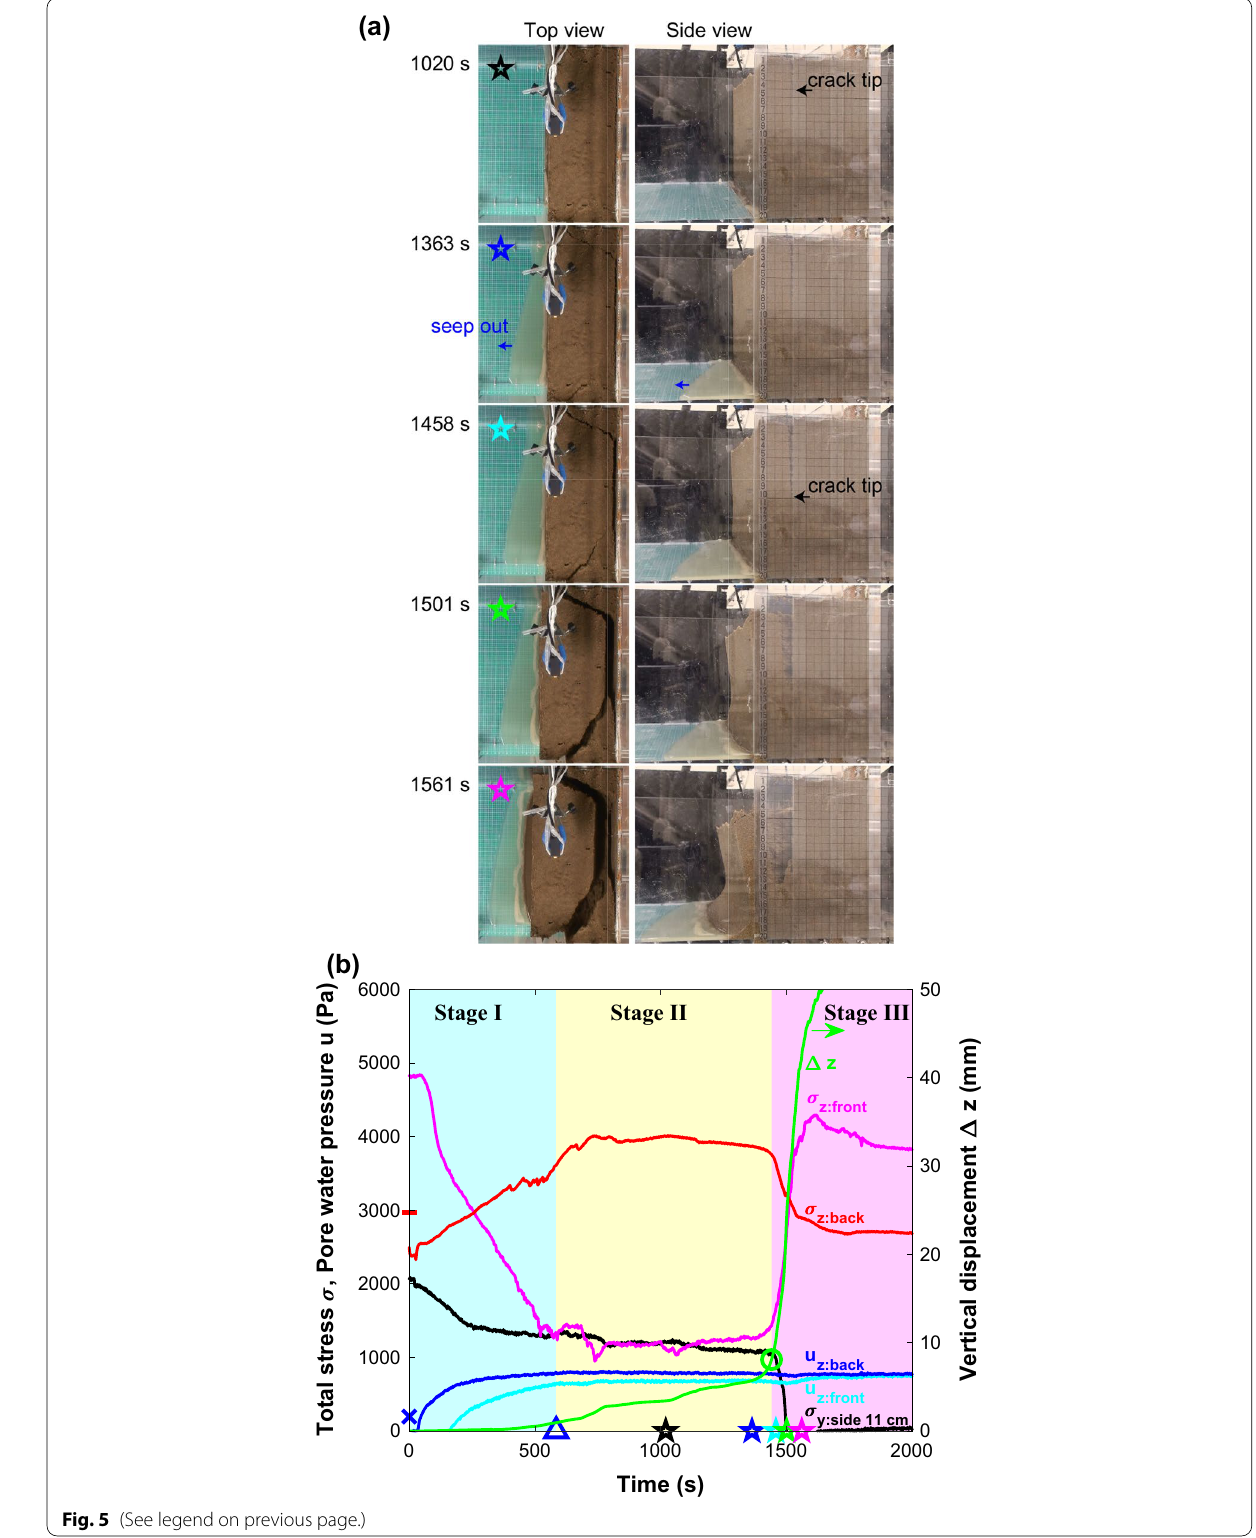
Fig. 5 (See legend on previous